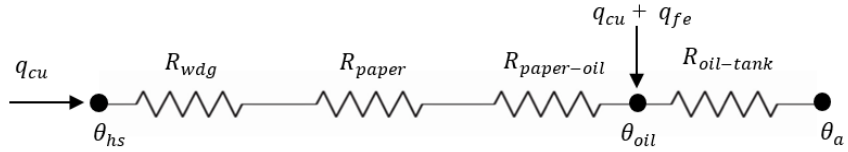
Figure 4. Thermal resistance equivalent circuit with a heat source and without the thermal resistance of the tank/radiator.